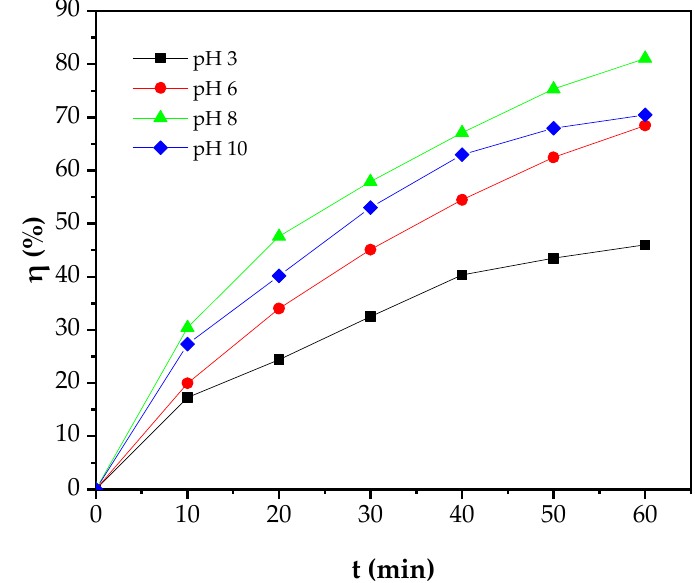
Figure 8. Effect of pH on Cu removal efficiency through photochemical process. Figure 8. E ff ect of pH on Cu removal e ffi ciency through photochemical